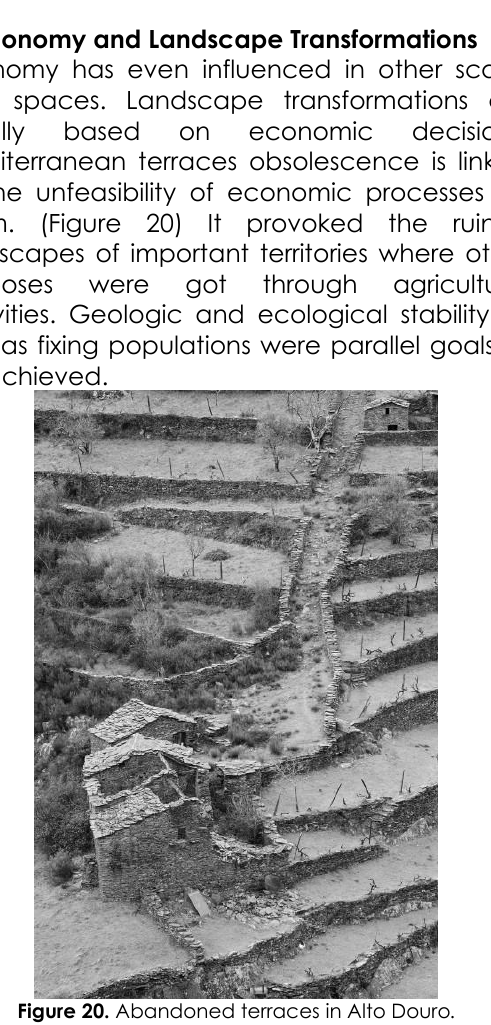
Figure 21. Plots redistribution in Galicia Spain 1964 .